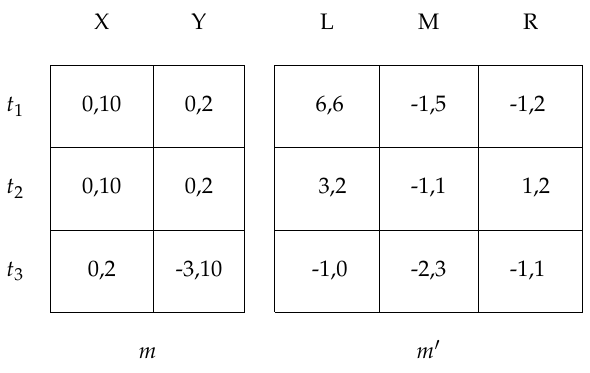
Figure 13. Modified signalling